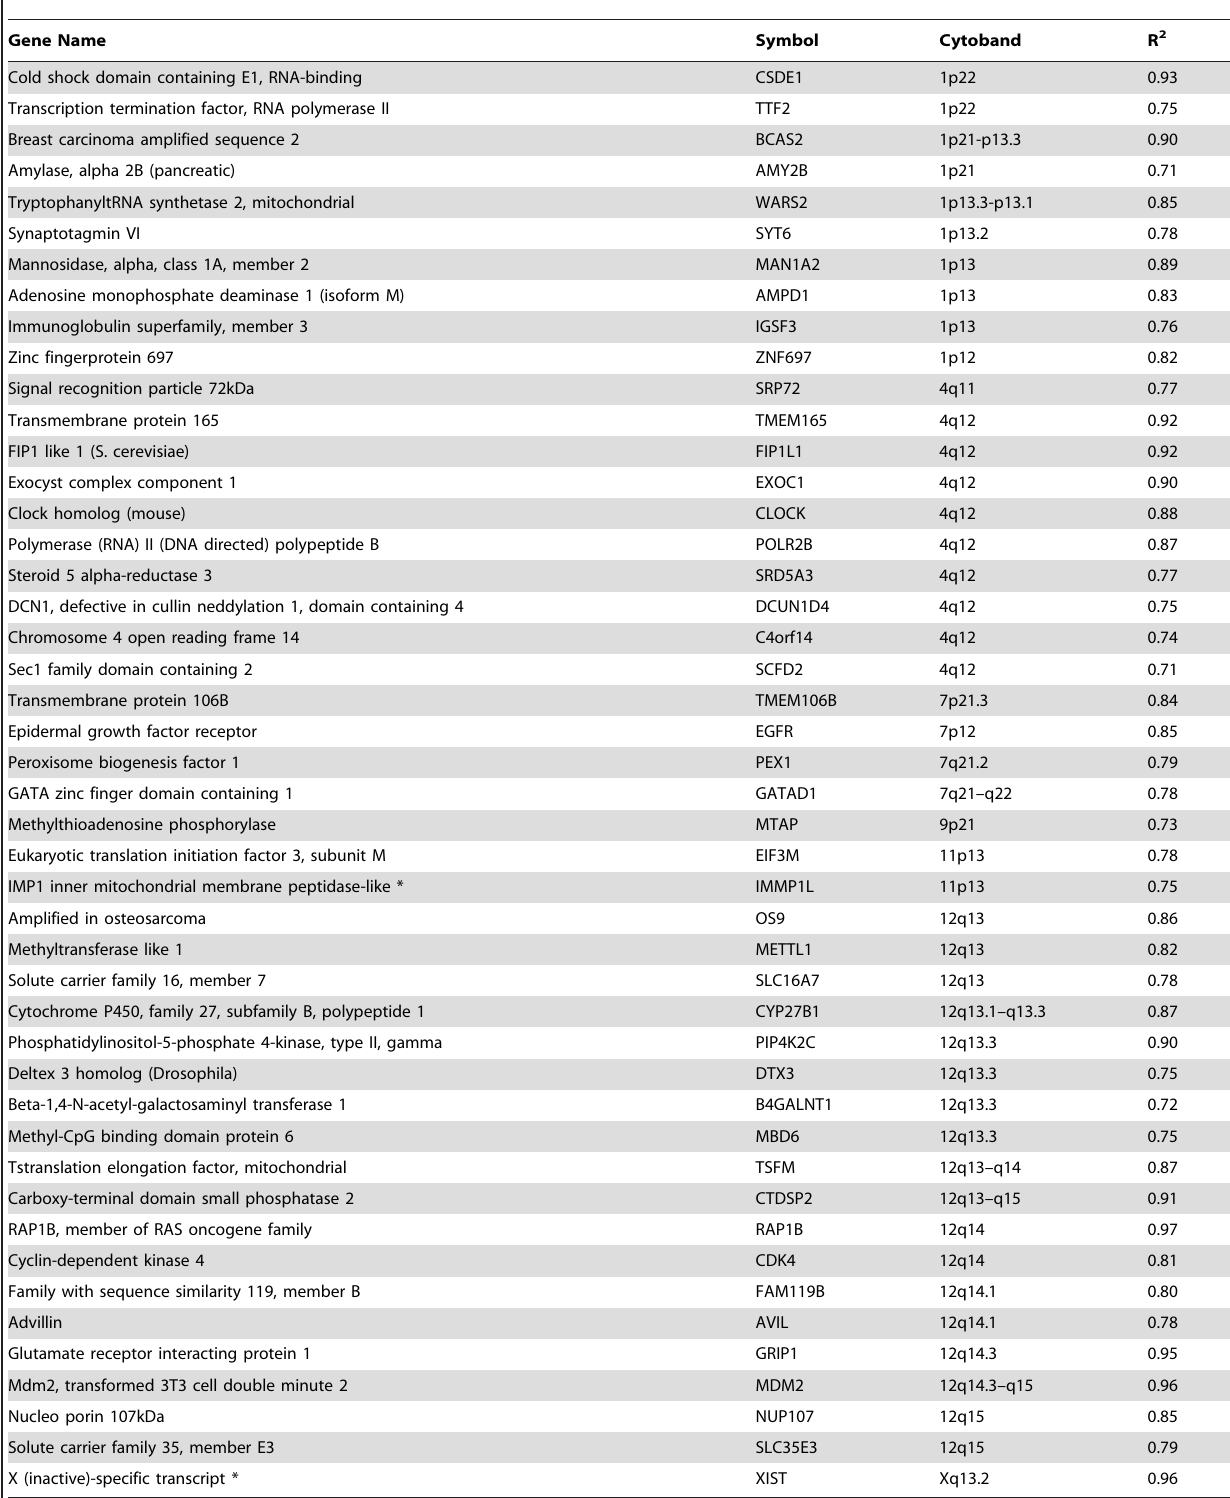
Table 2. Relationship between the CN alterations and gene expression levels for 12,445 genes analyzed in parallel with the SNP and GEP arrays, in GBM (n=